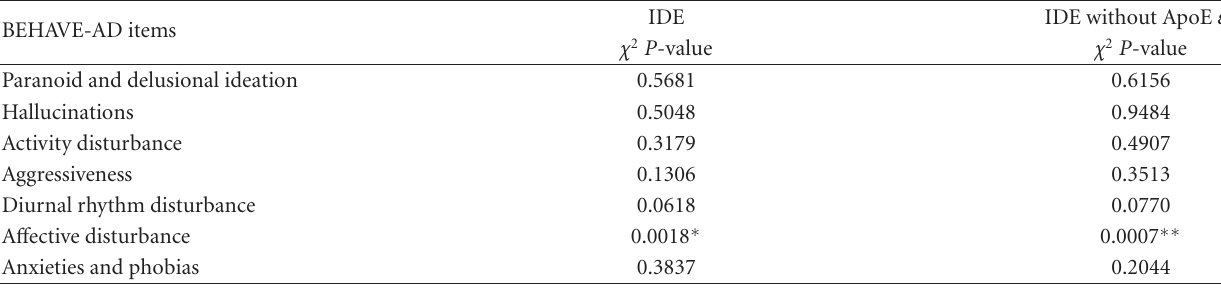
Table 2: χ 2 analysis between IDE genotype and BEHAVE-AD